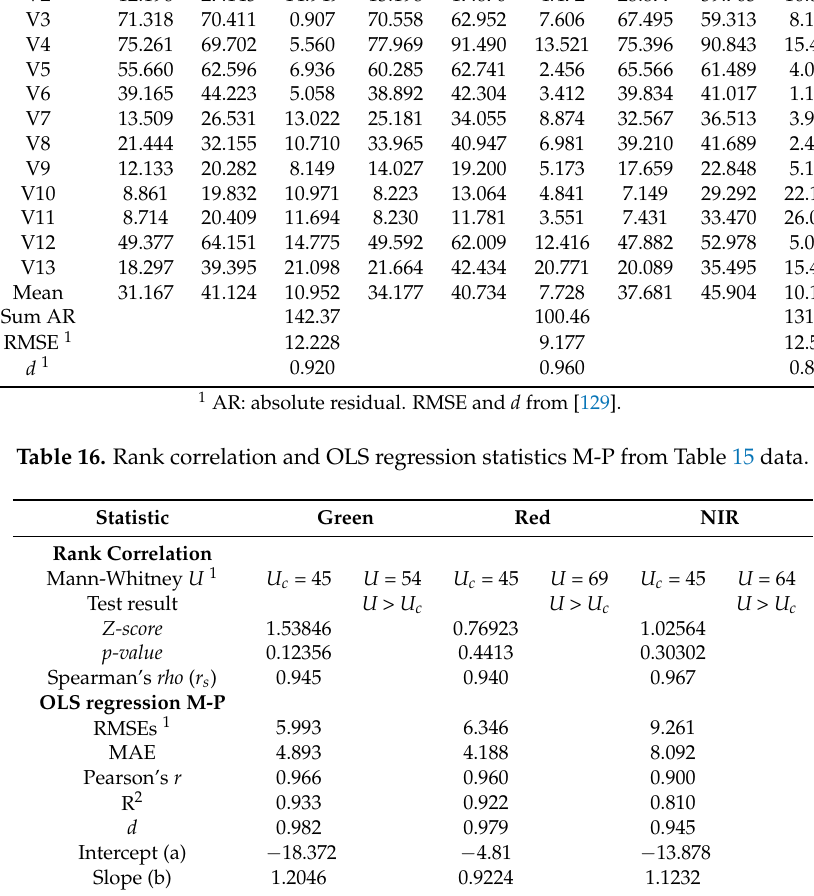
1 RMSEs from [129]. U test: no statistical difference in distributions at 95% confidence level. Plots of the measured and Dulux EL2 equation-predicted mean spectral reflectance values of the 13 validation samples are shown in Figures 9 and 10 below.